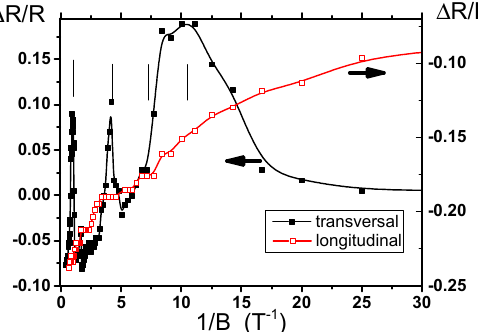
Figure 10. Transversal and longitudinal source drain resistivity ( Δ R/R) as a function of the inverse magnetic field B. Measurement on a nMOSFET with a dislocation network (V D = 3 V) at 3.1 K.